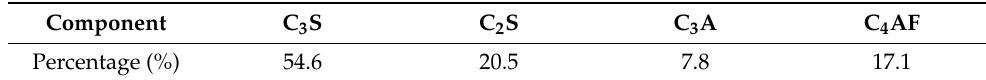
Table 2. Main components of cement clinker